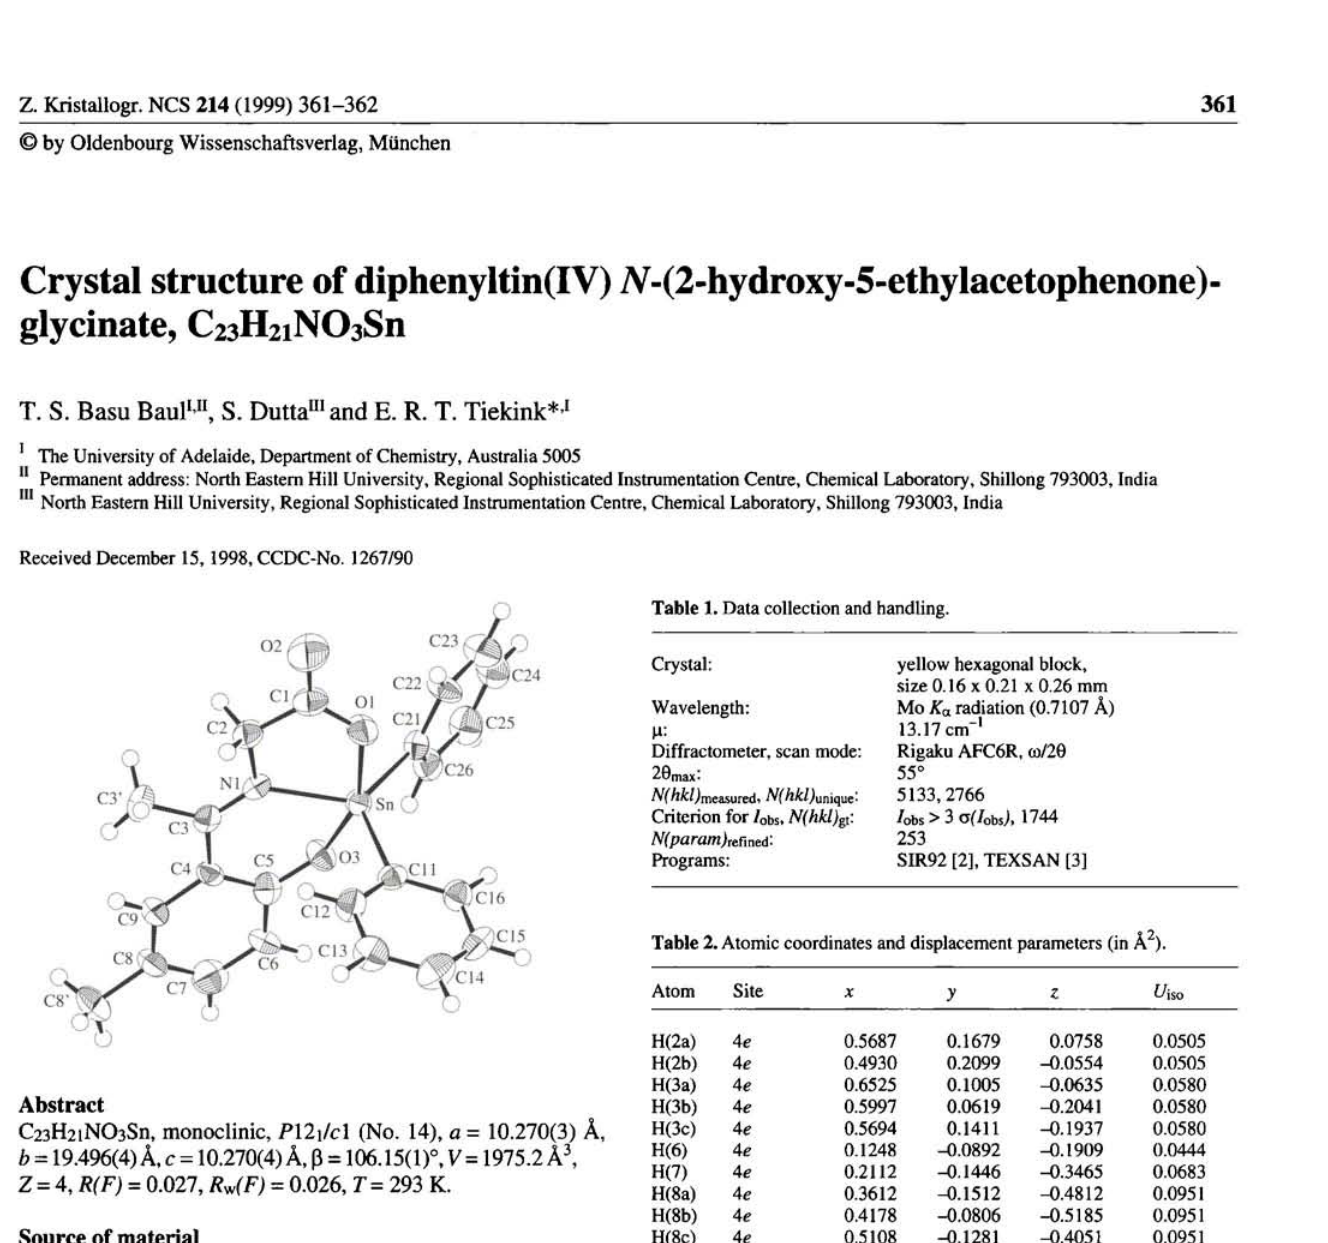
Table 2. Atomic coordinates and displacement parameters (in Â 2